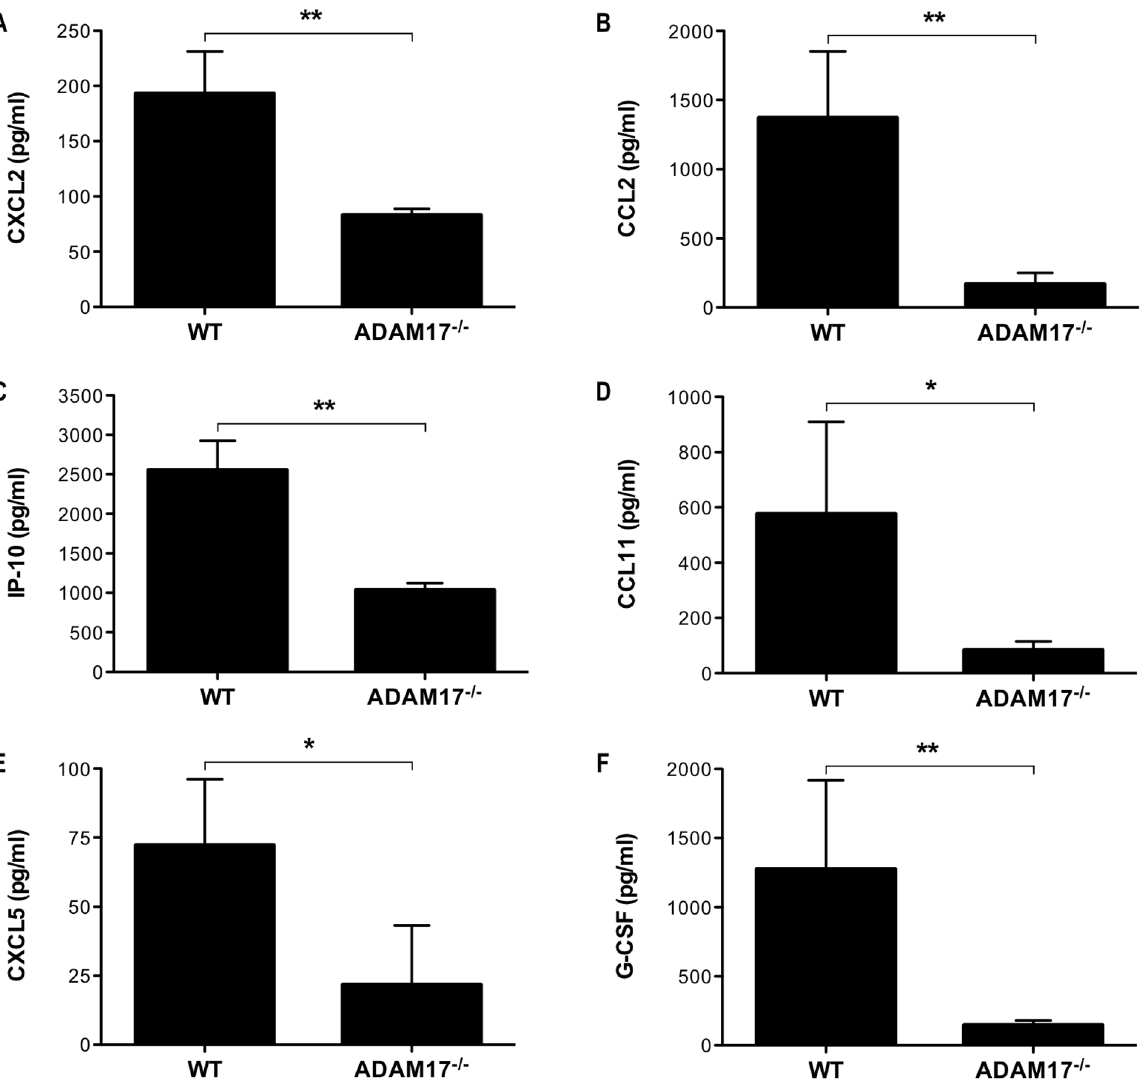
Figure 8. ADAM17 expression on transferred CD8 + T cells is required for enhanced airway inflammation. SPC-HA transgenic mice received 10 7 WT or ADAM17 2 / 2 HA-specific CD8 + T cells via tail vein injection. Twenty-four hours after T-cell transfer, cell-free BAL fluid was prepared and the levels of (A) CXCL2, (B) CCL2, (C) IP-10, (D) CCL11, (E) CXCL5, and (F) G-CSF were determined by Luminex assay. Data represent mean 6 standard deviation. Data are representative of two mice from two independent experiments with a total of 4 mice per group. * P , 0.05, ** P ,